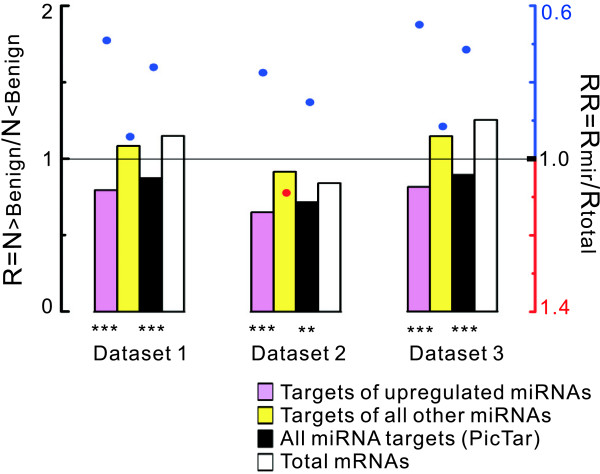
Transcript levels of the targets of up-regulated miRNAs and of all other miRNAs. All PicTar targets were divided into two groups. Group I contained the targets of 39 significantly up-regulated miRNAs in prostate cancer reported by Volinia et al. (36 of the 39 had conserved PicTar targets). Group II contained all other miRNA targets. Pink and yellow bars represent Rmir values of group I targets and group II targets, respectively. Black and white bars represent R values of all miRNA targets and total mRNAs, respectively. RR values and P values are analyzed as in Figure 1A.